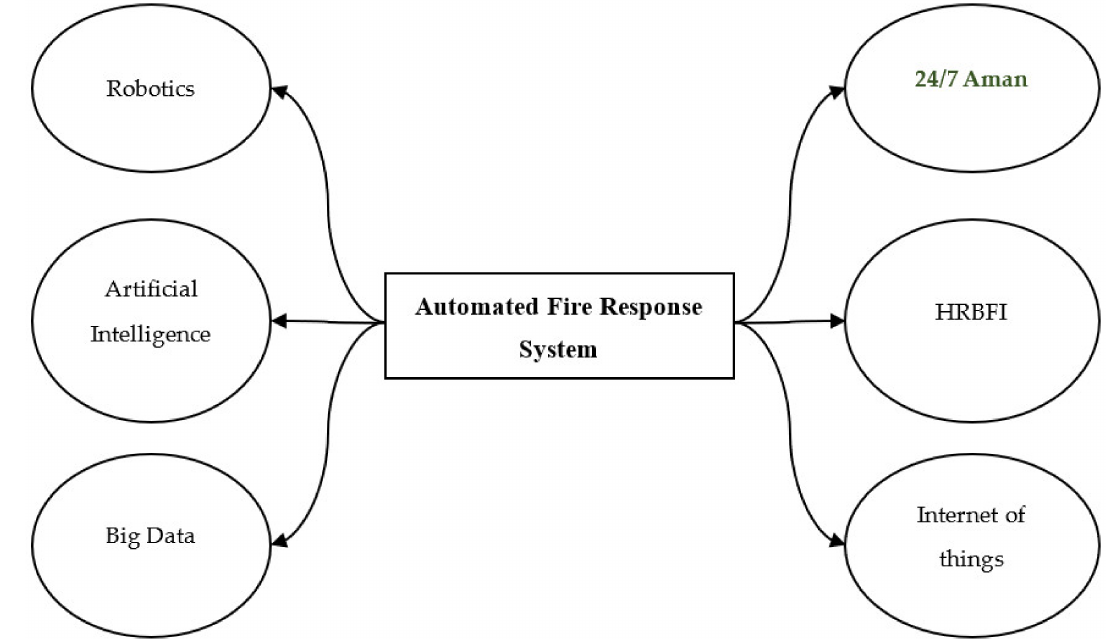
Figure 2. Automated fire response